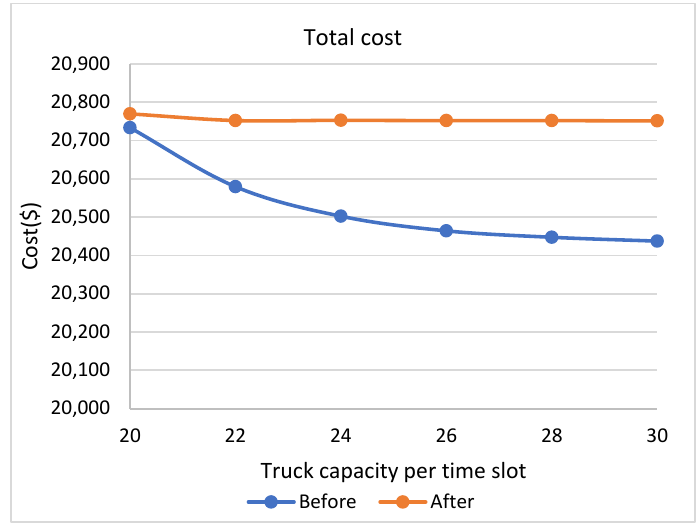
Figure 16. The total cost before and after leveling the workload.